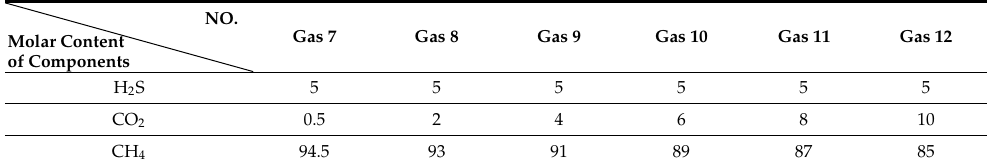
Table 4. High-sulfur-content natural gas mixture components.